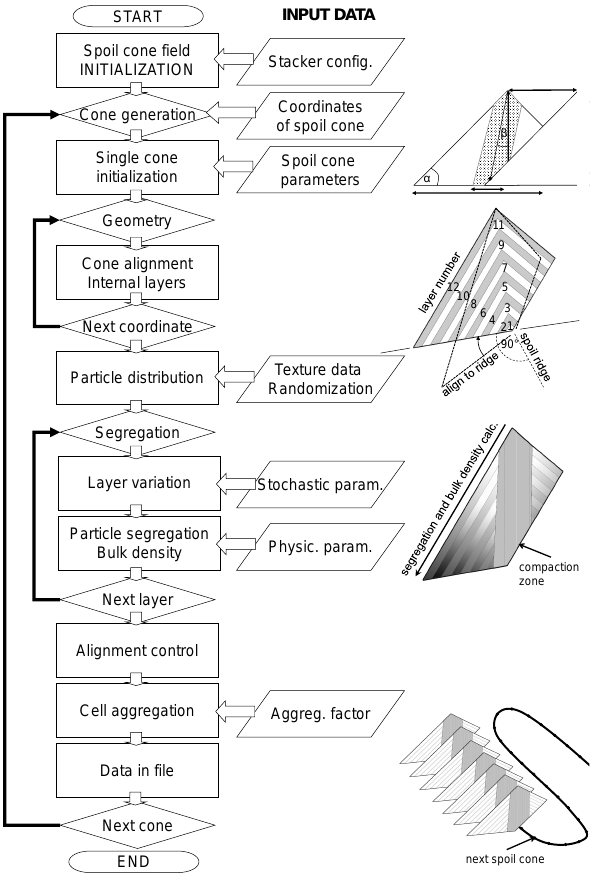
Fig. 5. Simplified flow chart diagram of the structure generator pro- gramme. Sketches on the right hand side illustrate the cone con- struction steps.